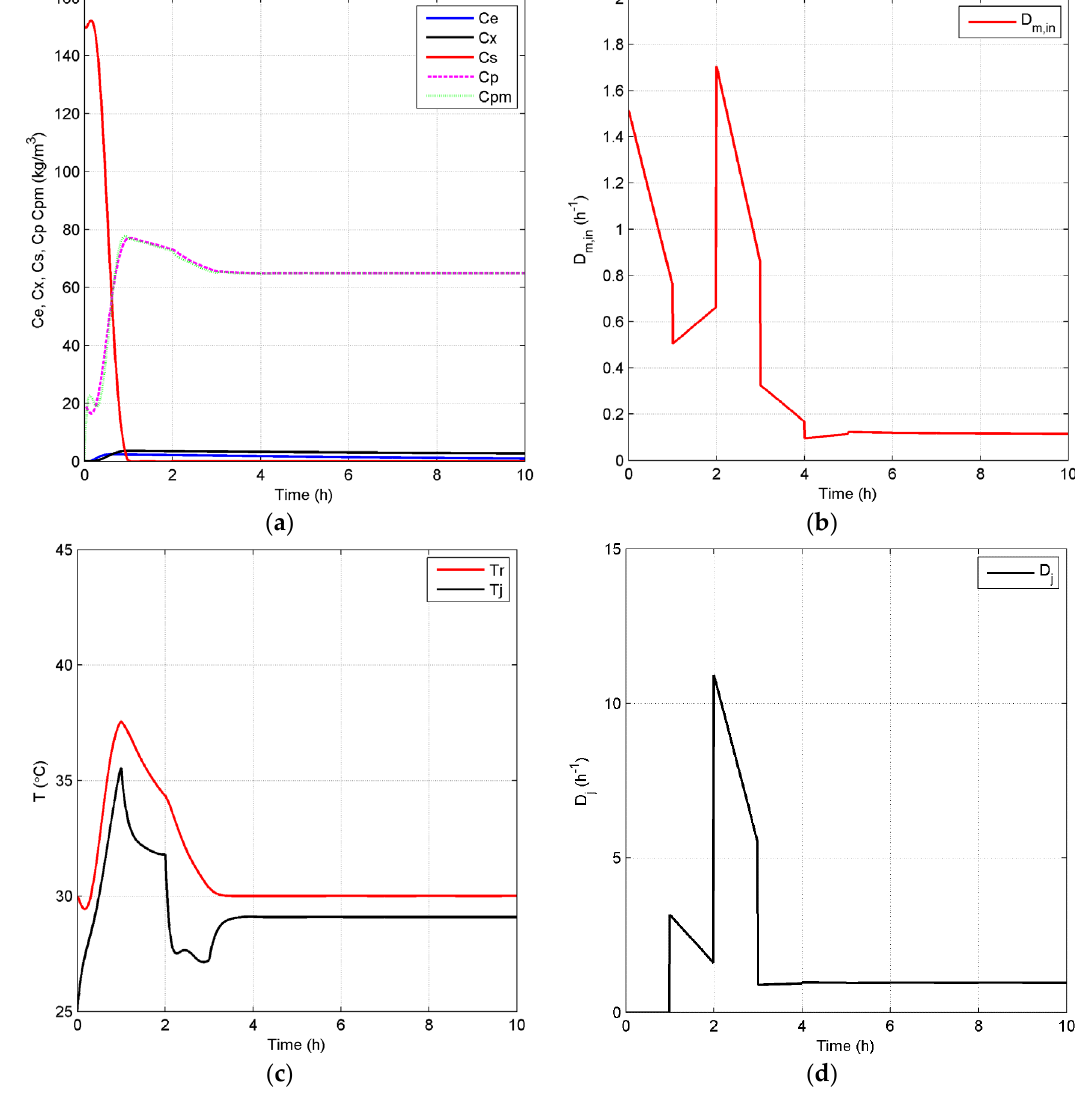
Figure 6. Closed-loop simulation profiles (Case 1): concentrations ( a ), D m,in ( b ), temperatures of the fermentor and jacket ( c ) and D j ( d ).